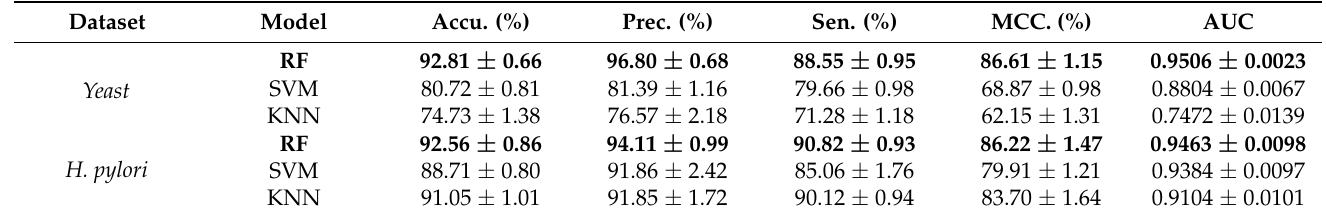
Table 6. The experimental results compared with other prediction models in the Yeast and H. pylori